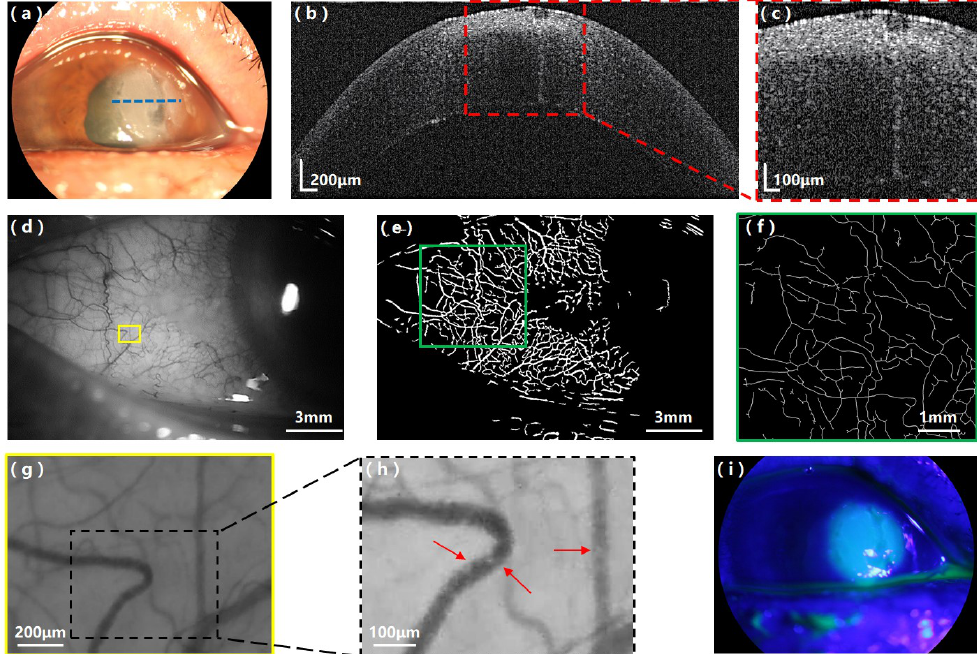
Figure 4. Experimental results on the keratitis patient with the multi-modal anterior eye imager. ( a ) Appearance image of the keratitis patient’s eye; the blue dashed line indicates the UHR-OCT scanning position. ( b ) UHR-OCT image of the inflamed cornea and ( c ) the zoom-in area showing the highly reflective, inflamed lesion. ( d ) The bulbar conjunctival vessel network image of the keratitis patient; the yellow box indicates the location where the representative video clip (Video s2) was taken. ( e ) The segmented vessel network image and ( f ) the skeletonized vessel network image of the selected region (green box) in ( e ). ( g ) A representative conjunctival vessel image captured from the bulbar conjunctival blood flow video clip (Video s2). ( h ) Zoom-in area of ( g ) showing resolved clusters of red blood cells (red arrows). ( i ) Fluorescein stain image of the keratitis patient. Table 1. Comparison of the quantitative vessel parameters of the healthy and keratitis patient.